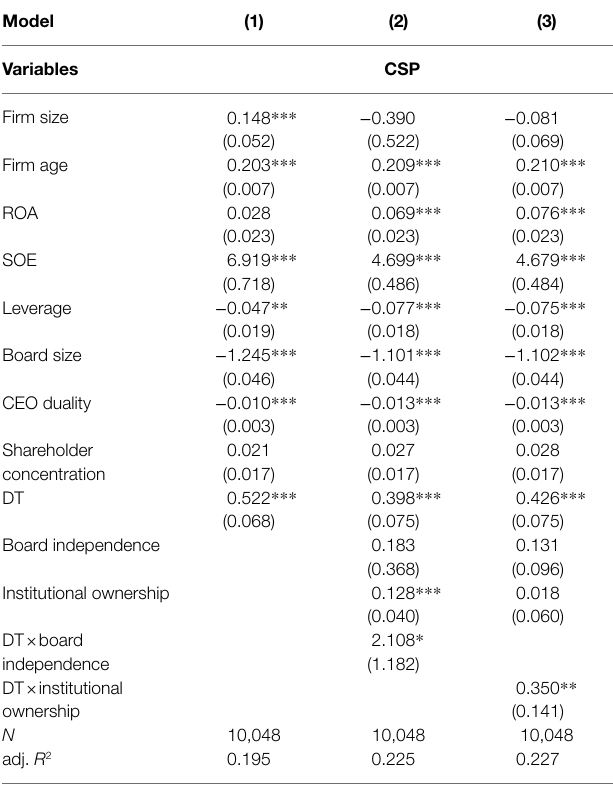
TABLE 8 | Robustness check: Second stage of 2SLS estimations.